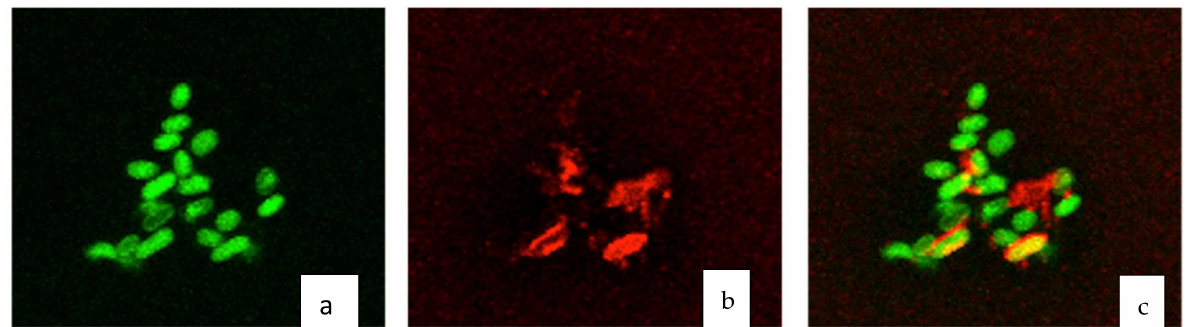
Figure 2. Confocal images of D. alkanexedens EPS with fluorophore stains: ( a ) nucleic acid stain Syto 9 TM ; ( b ) carbohydrate- binding conconavalin A and ( c ) overlayed image. Bacterial cells are 1–2 microns in